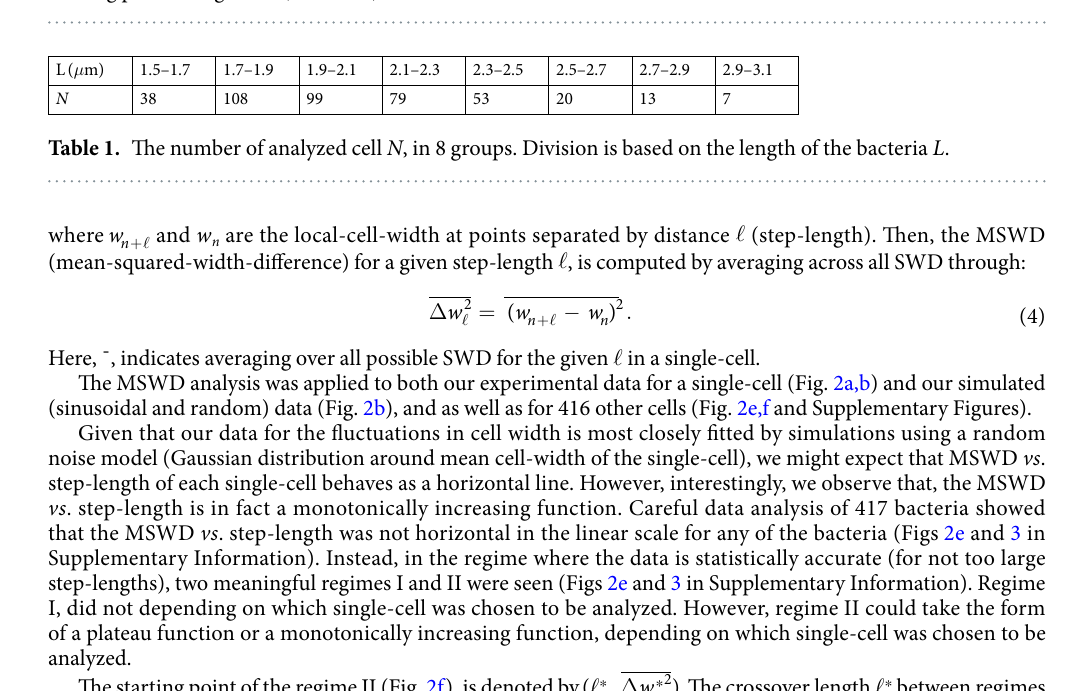
Figure 2. Analysis of the local-cell-width in the cylindrical part of E . coli cells. ( a ) Variation of the local-cell- width ( w in Fig. 1) from pole to pole and along the axial direction ( y ) of one cell. ( b ) Variation of the local-cell- width ( w ) of the cylindrical part of a cell: experimental data of the cell, which is shown in ( a ), sinusoidal simulated data, and random simulated data. ( c ) Mean-squared-width-difference (MSWD) of ( b ) (data belongs to one cell). ( d ) Cartoon of multi-domain morphological structures in the cylindrical part of a cell. ( e ) Mean- squared-width-difference vs . step-length of 38 cells with 1.5–1.7 μ m length. ( f ) Five selected data of ( e ), and the starting point of regime II ∆  ⁎ ⁎ w ( , ) 2 .